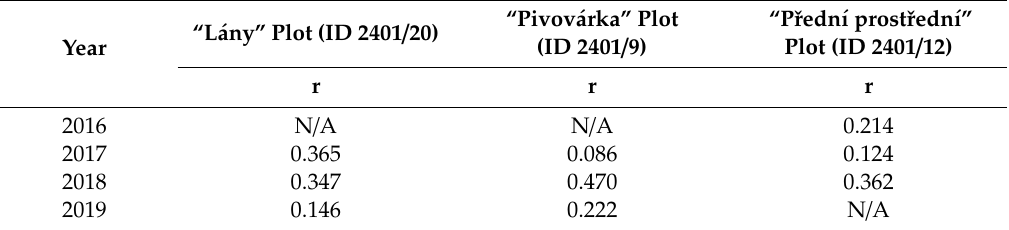
Table 4. Pearson correlation coe ffi cient (Pearson’s r) at a 95% significance level. Note that “N / A” means “not applicable”, as field machinery measurements were not available for such a combination of a plot and